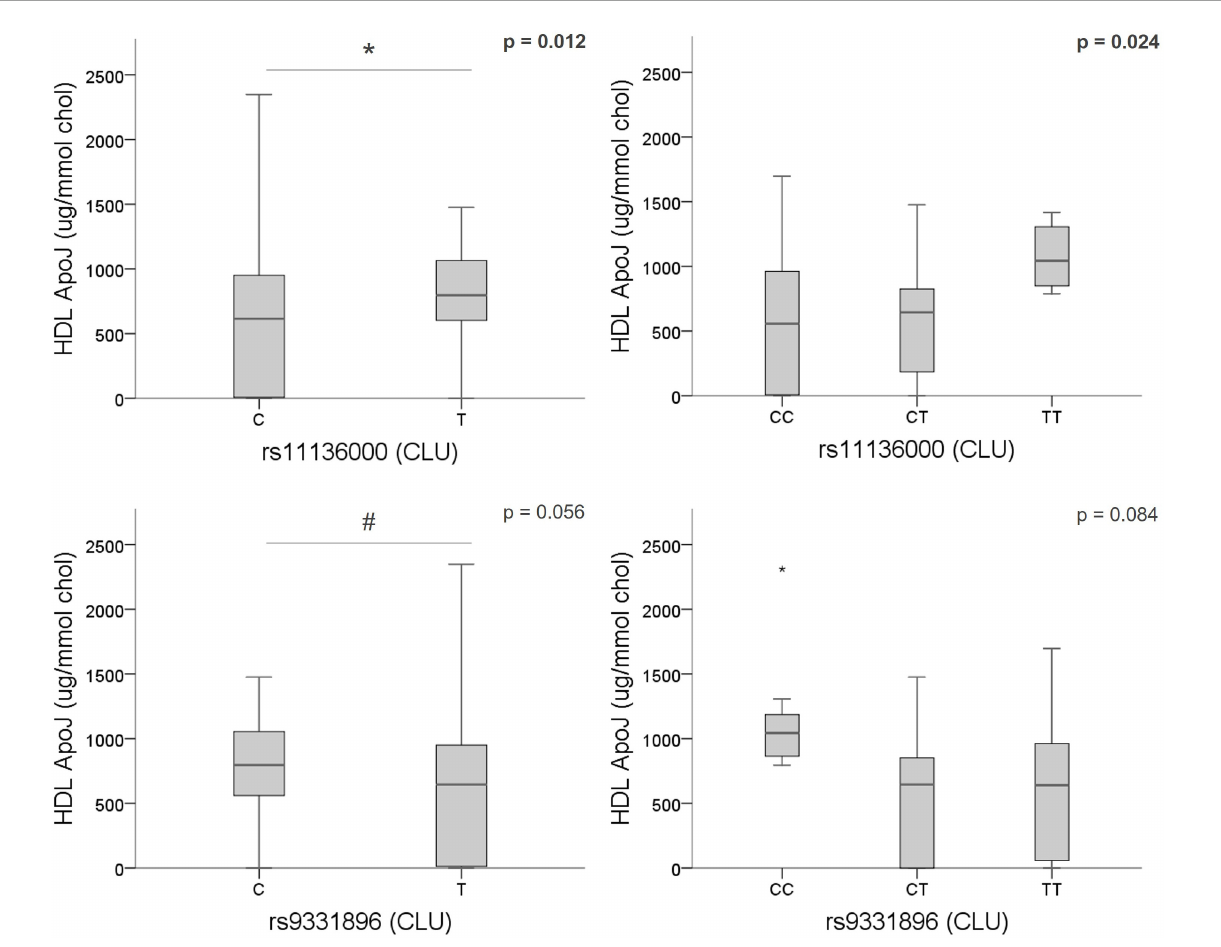
FIGURE2 Association of CLU SNPs [rs1136000 (T), rs9331896 (C)] with ApoJ content in HDL. Boxplot representation of ApoJ content in HDL expressed as µ g of ApoJ per mmol of cholesterol in HDL according to CLU SNPs alleles. * p < 0.05; # p <